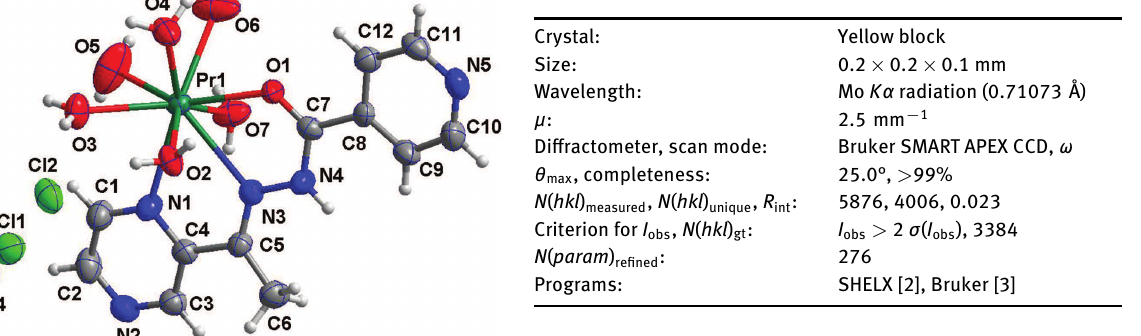
Table 1: Data collection and handling.